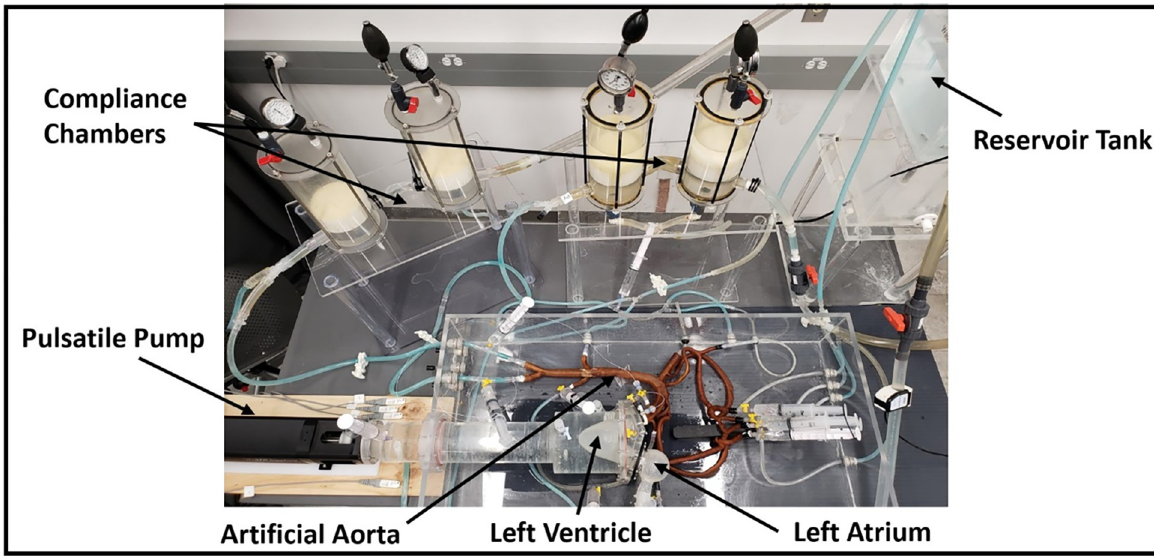
Fig 3. Picture of the complete in-vitro circulation system consisting of the LV, the aorta, the vascular components of the systemic circulation, and the left atrium.